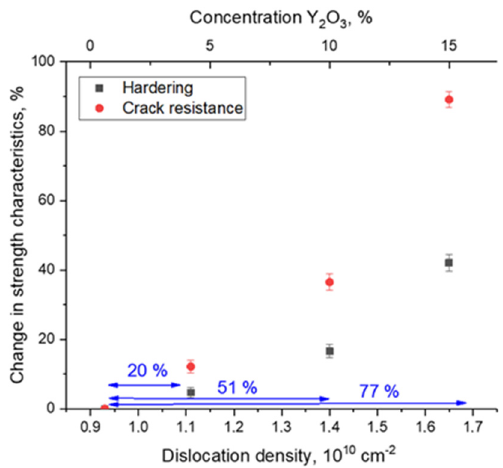
Figure 5. Comparison results of dislocation density changes on ceramic